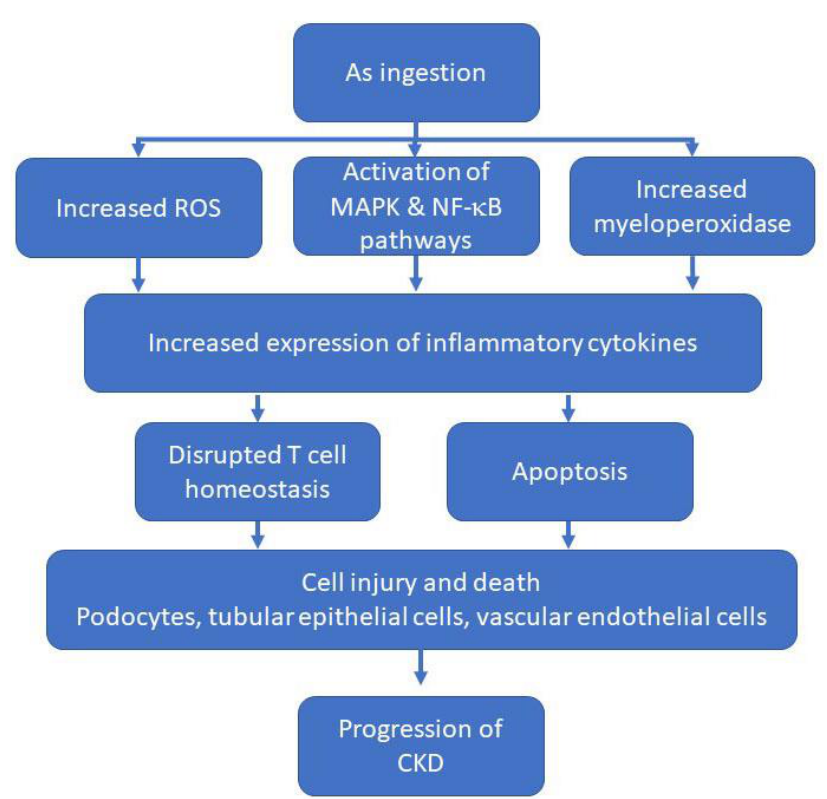
Figure 3. Flowchart summarizing major effects of arsenic (As) exposure in relation to the progression of CKD. As-induced injury is a complex, multifactorial process that cannot be summarized completely in a single figure. Thus, while this figure includes major pathways of As-induced injury, it does not cover all mechanisms and routes of injury.